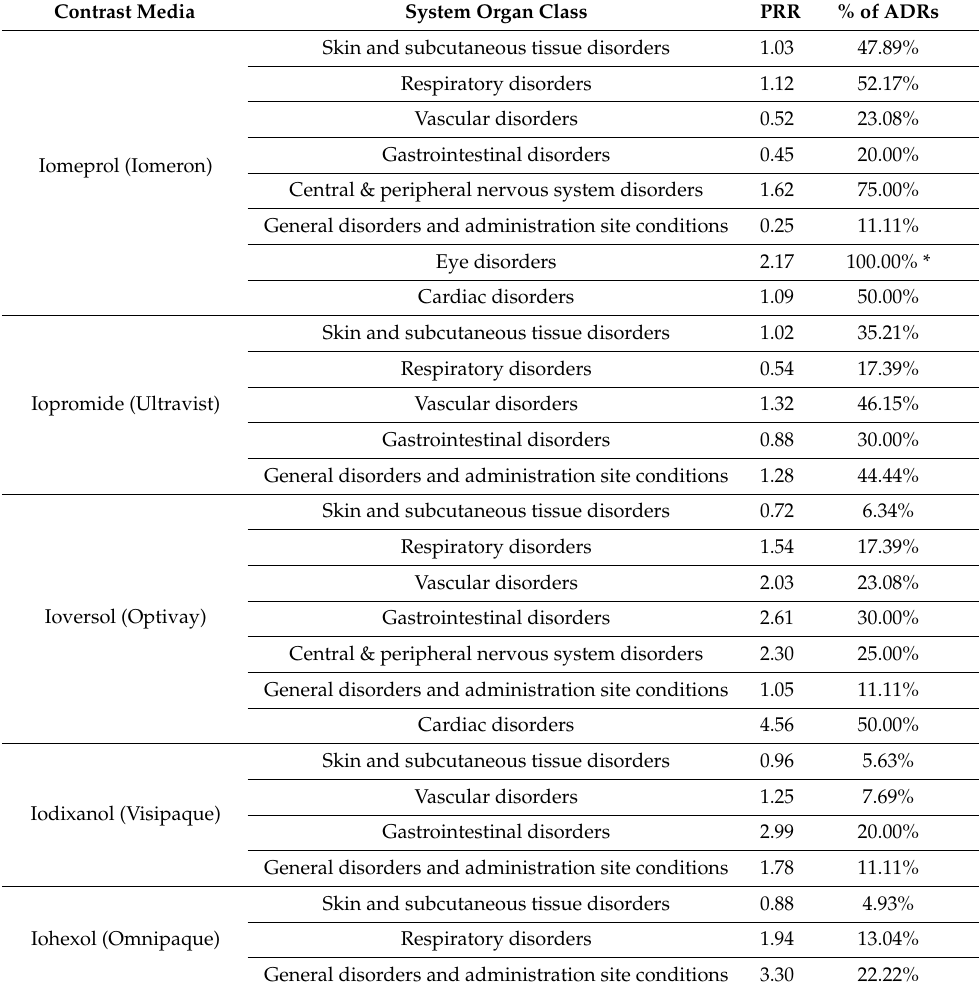
Table 5. Proportional reporting ratio of iodinated contrast media; * presents a single